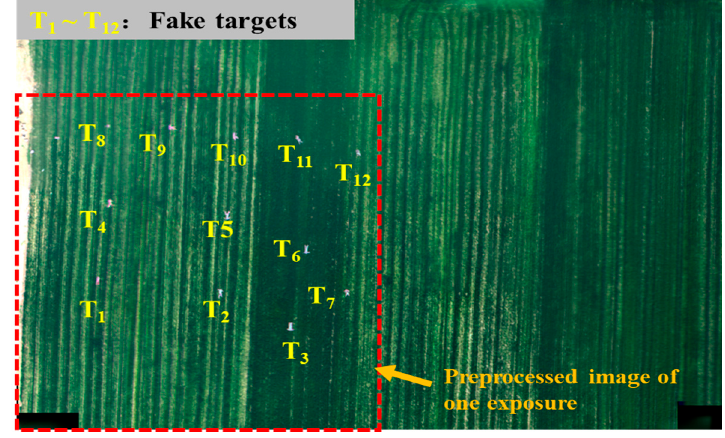
Figure 12. The complete reflectance panorama in Scenario 1.